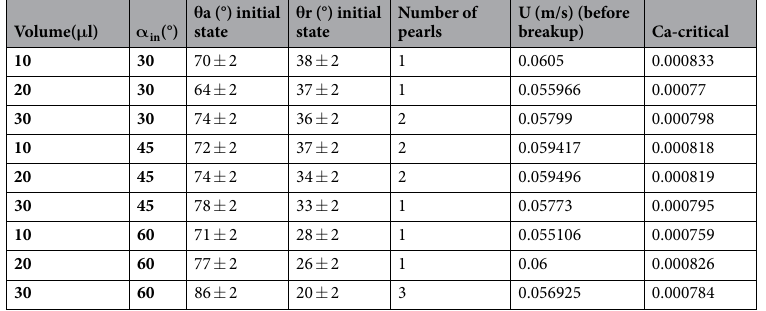
Table 2. Critical capillary number for pearl generation and number of pearls in the